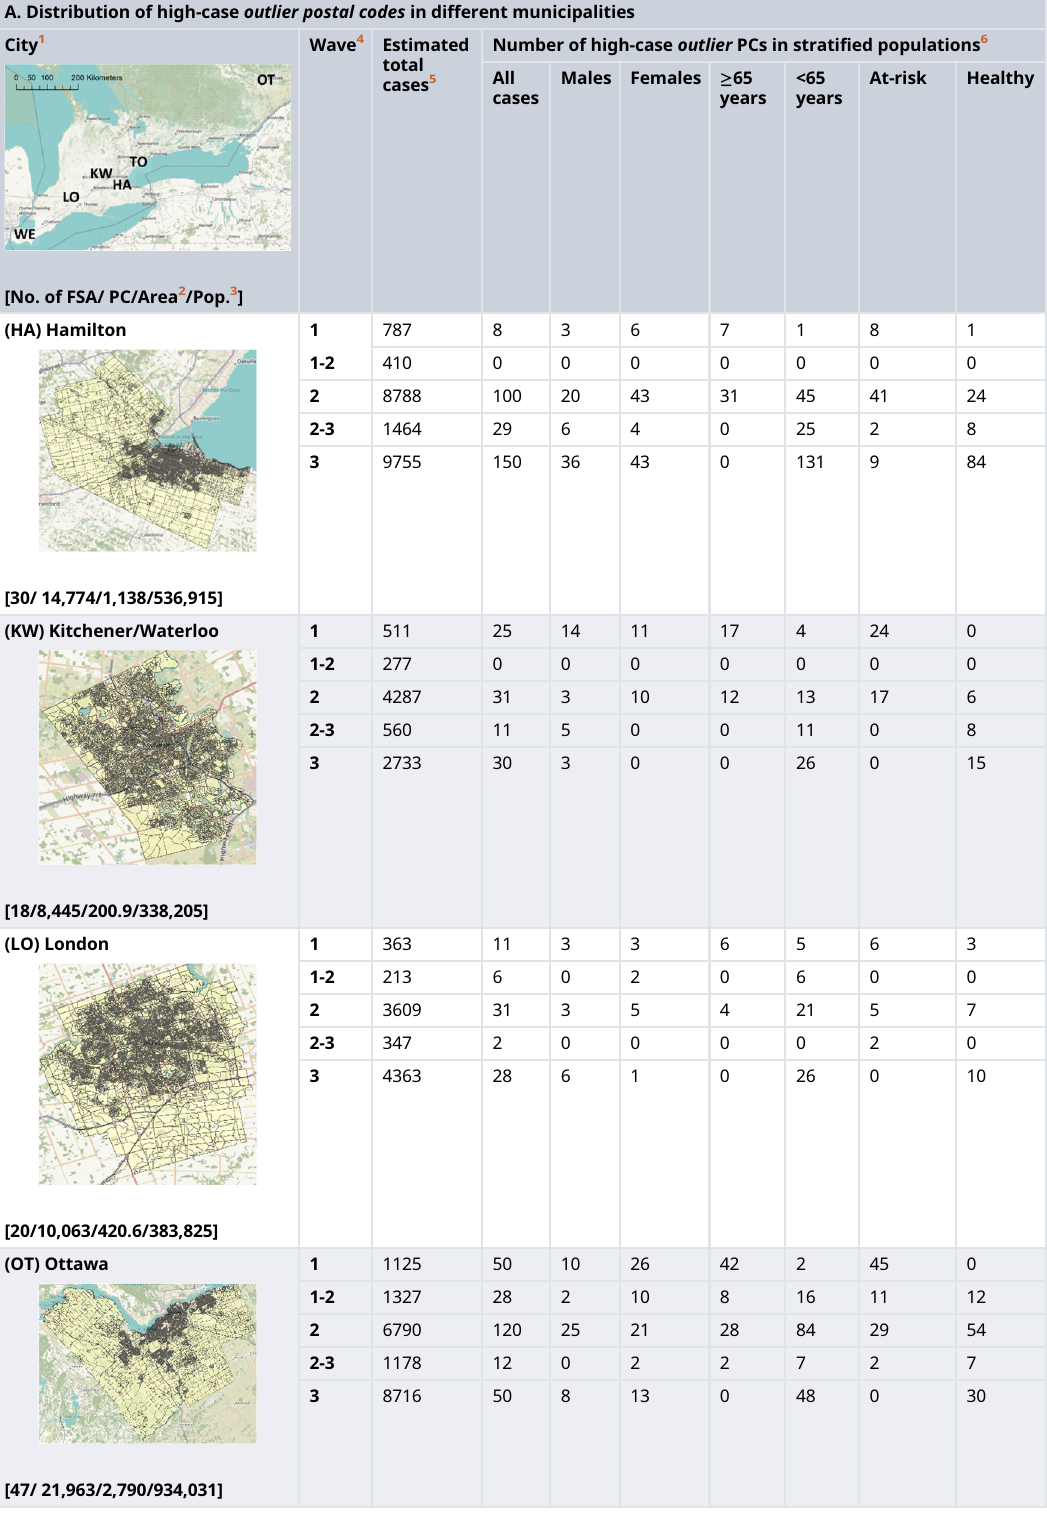
Table 1. Number of postal codes with high case clusters and outliers by location and wave. A. Distribution of high-case outlier postal codes in different